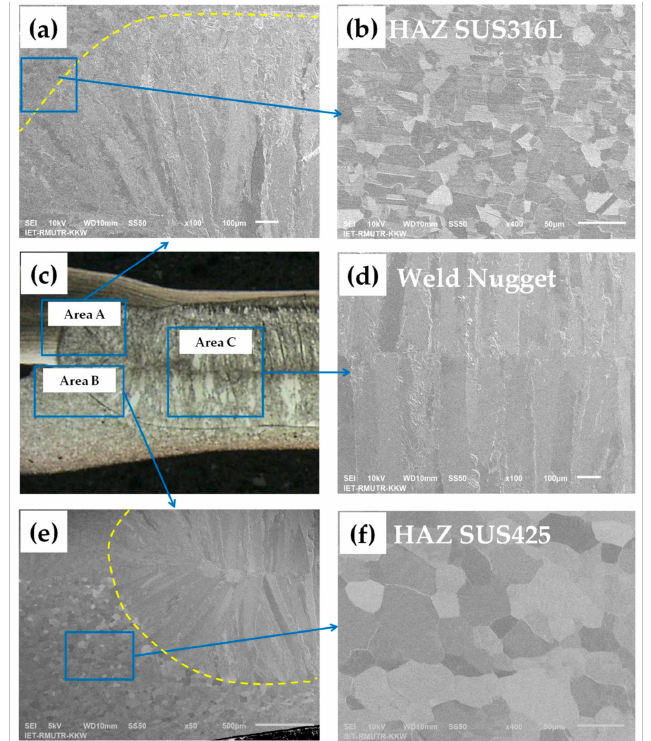
Figure 16. Cross-sectional microstructure of weldment under a 10.0 kA weld current and 25-cycle welding time.